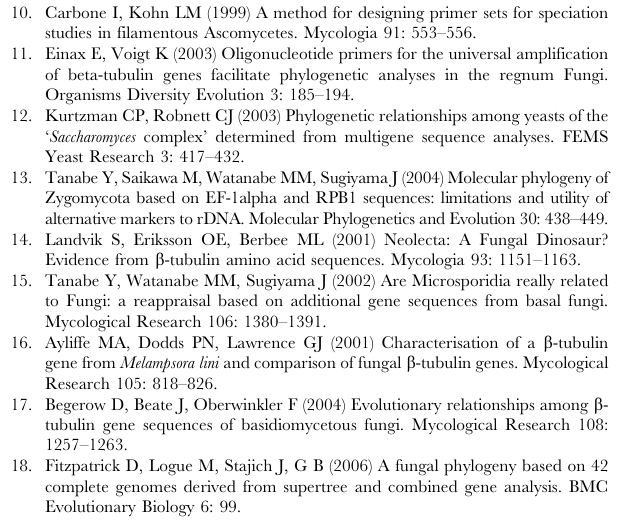
Figure S2 Cross comparison of the three protein datasets (FUNYBASE, PHYLOME-T60 and OrthoMCL- DB) used as the initial step of PHYLORPH. (A) Number of orthologs shared between two or three databases (showed at the intersections of the Venn diagram) or exclusive to one database (into the circles); (B) Number of fungal species exclusive to one database or shared between two or three databases. Table S1 Fungal protein and genome sources used in PHYLORPH. Table S2 List of the 40 different PHYLORPH runs performed for the computational testing. Those destined to the experimental validation are indicated in